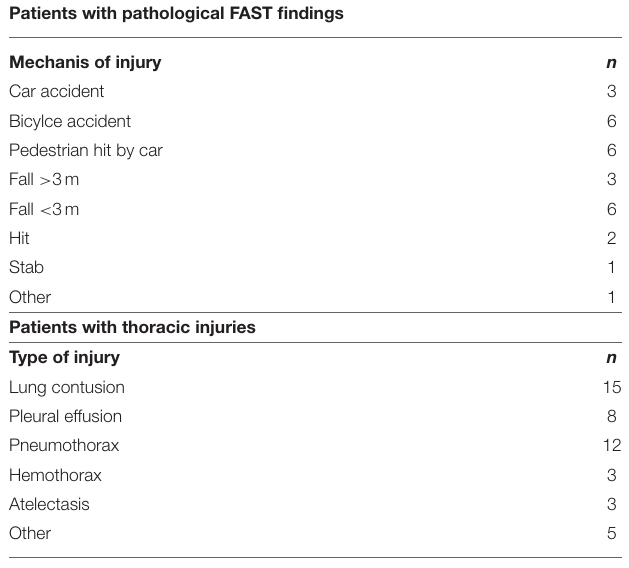
TABLE 1 | Mechanism leading to pathological findings in FAST (focused abdominal sonography for trauma) and thoracic injuries. Patients with pathological FAST findings